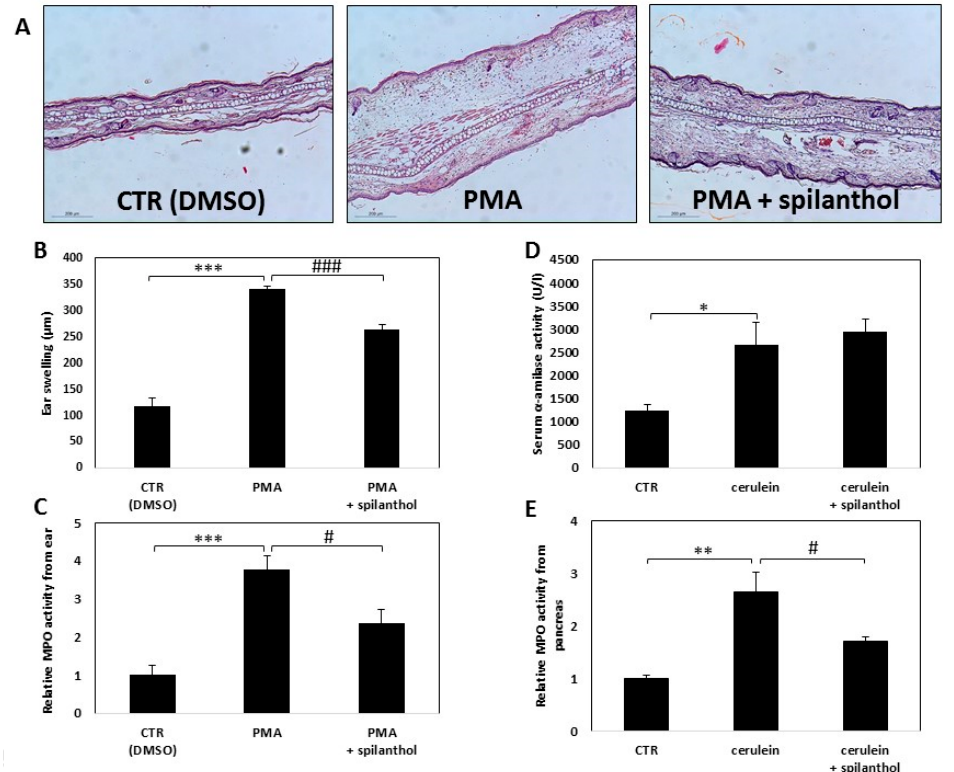
Figure 7. Spilanthol alleviates symptoms and decreases signs of inflammation in experimental dermatitis and reduces leukocyte infiltration in pancreatitis. ( A ) Dermatitis was induced as described in the Methods section. Micrographs of H&E stained ear sections from mice topically treated with vehicle, PMA, or PMA + spilanthol. ( B ) Spilanthol (10 µM solution, 10 µL applied topically on both sides of the ear) reduced the edematous response as demonstrated by decreased ear thickness. ( C ) Spilanthol reduces leukocyte infiltration into the inflamed ear, as shown by decreased MPO activity in the tissue. ( D ) Spilanthol (30 mg/kg) was ineffective in reducing pancreatic cell damage in the mouse cerulein-induced acute pancreatitis model, as indicated by serum α -amylase levels. ( E ) Spilanthol suppressed neutrophil infiltration into the pancreas as indicated by the decreased MPO level in the tissue. (* p < 0.05, ** p < 0.01, *** p < 0.001, # p < 0.05, ### p <